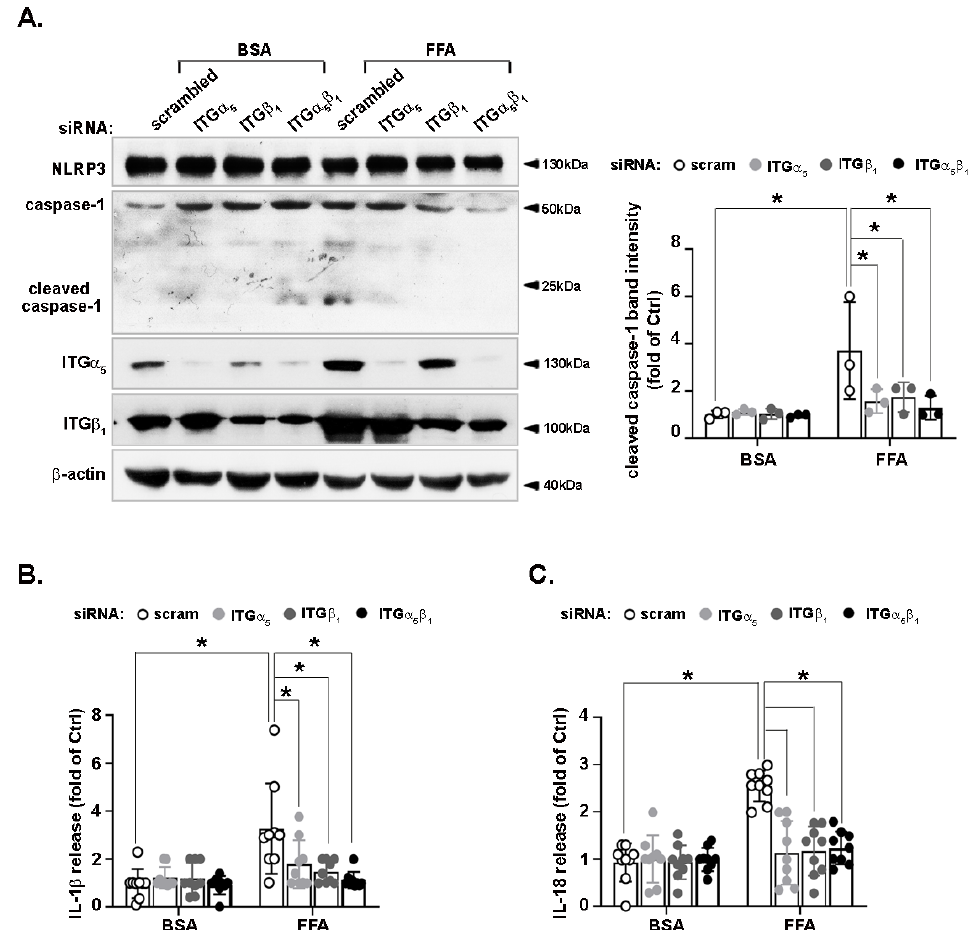
Figure 6. Effects of integrin α 5 β 1 on the FFA-activated NLRP3 inflammasome in hepatocytes. LO2 hepatocytes were transfected with scrambled, integrin α 5 , integrin β 1 , or integrin α 5 + β 1 siRNA, then treated with FFA (1 mM) for 24 h and ATP (5 mM) for 30 min before harvest. Protein levels of NLRP3, caspase-1, CCN1, and β -actin in cell lysates were analyzed by immunoblotting ( A ). The immunoblots shown are representative of three independent experiments. Quantifications of band intensity were normalized to β -actin. The concentrations of IL-1 β ( B ) and IL-18 ( C ) in the conditioned medium were determined by ELISA. ELISA data shown are from three independent